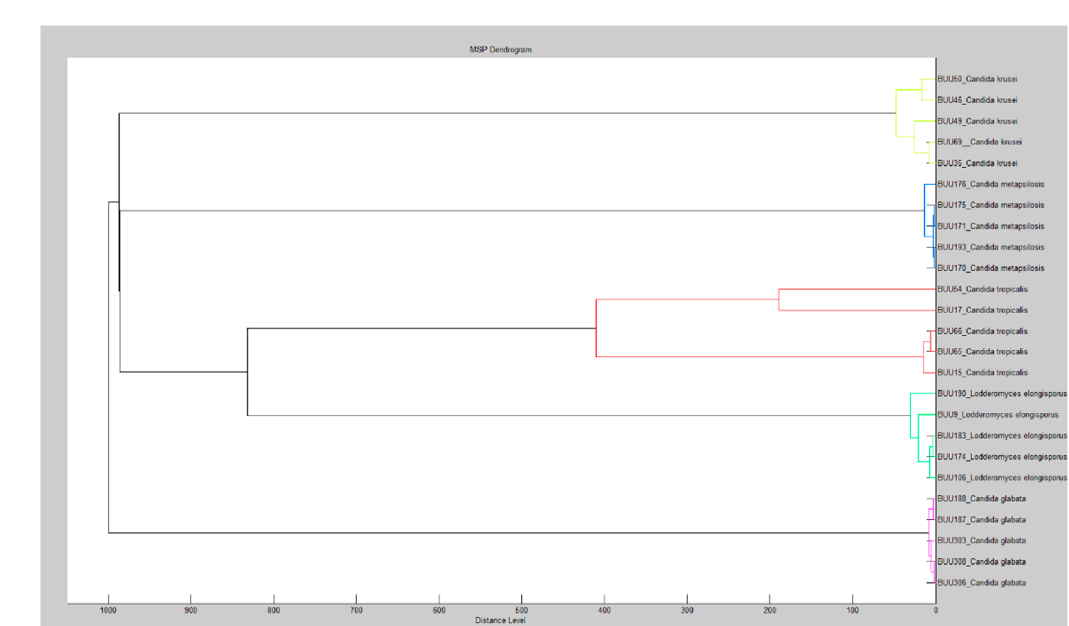
Figure 1. Representative spectra profiles of six common yeast species colonized in pigeon drop- pings.